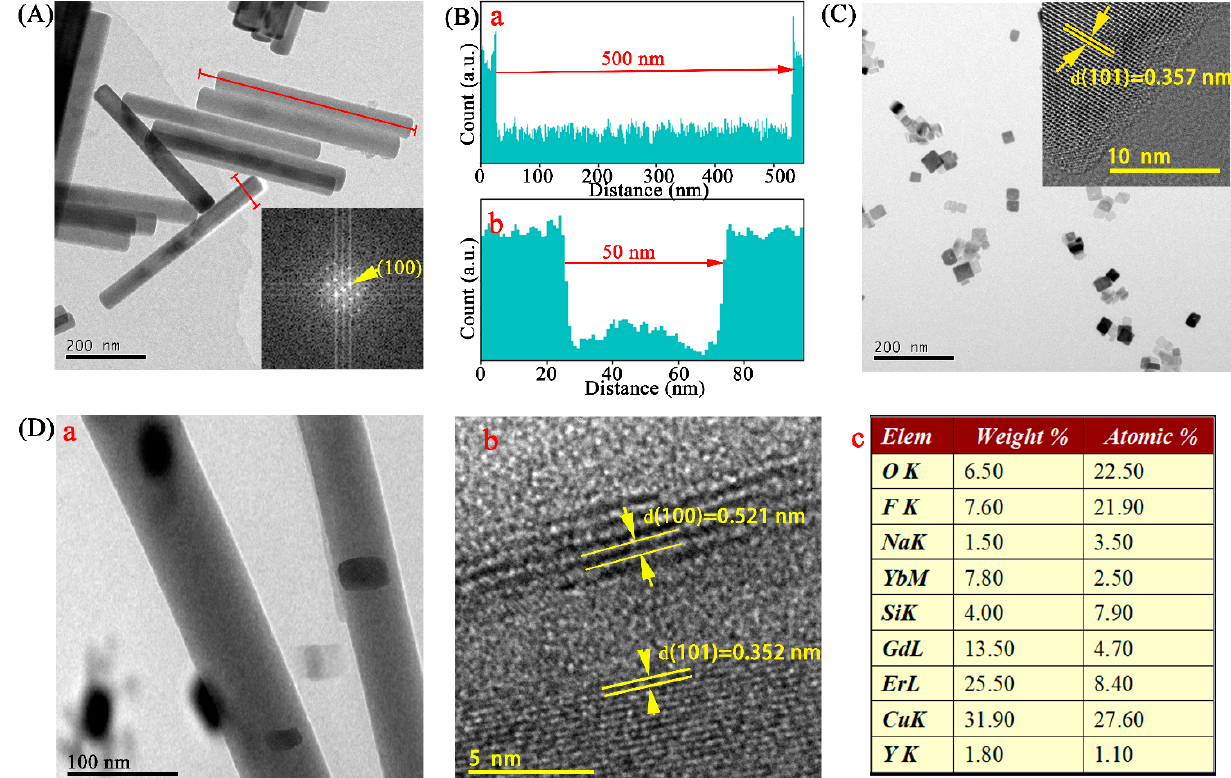
Figure 2. ( A ) TEM image of UCNPs, with insert showing the fast Fourier transform pattern. ( B ) Length ( a ) and diameter ( b ) analyses of ( A ). ( C ) TEM and HRTEM (high resolution TEM) images (inset) of R-TiO 2 . ( D ) TEM image ( a ), HRTEM image ( b ), and elemental compositions analysis ( c ) of UCNPs@ R-TiO 2